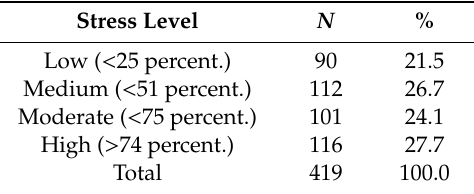
Table 3. Distribution of stress levels in the sample.